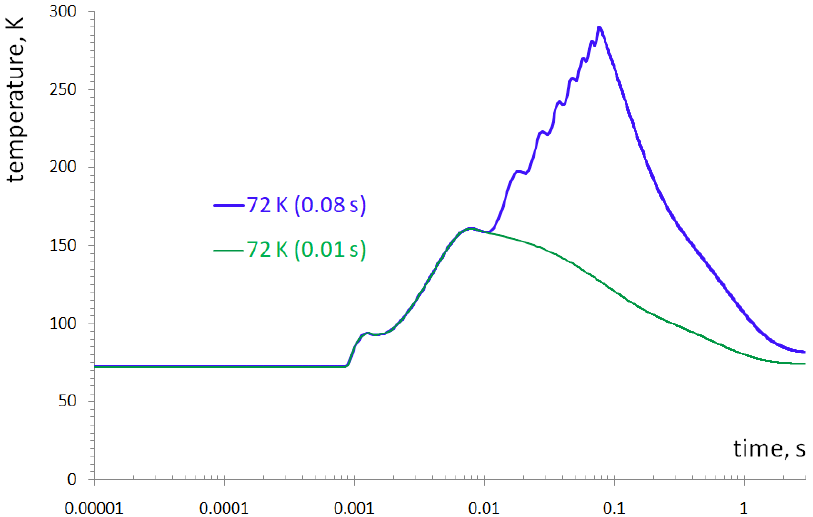
Figure 16. Temperature changes of the limiter HTS tape during short-circuit (0 s–0.08 s) and cooling (0.08 s–3 s)—“72 K (0.08 s)” and during short circuit (0 s–0.01 s) and cooling (0.01 s–3 s)—“72 K (0.01 s)” for the initial